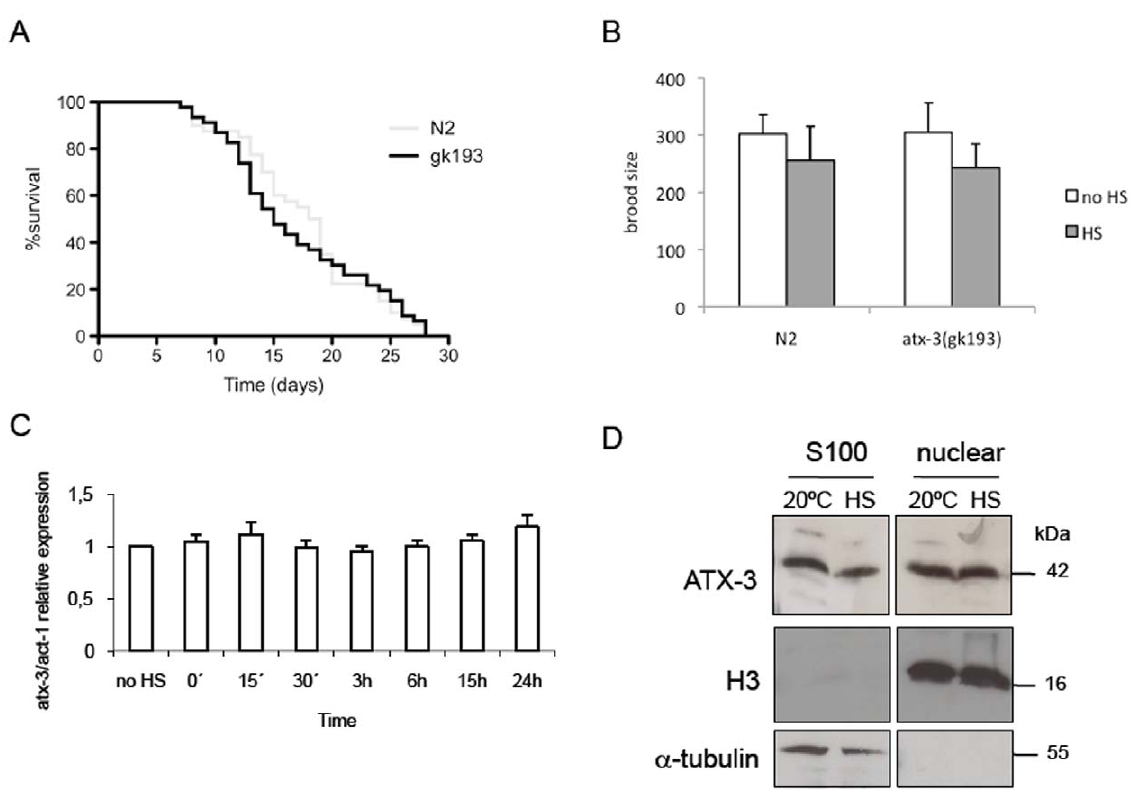
Figure 6. Atx-3 expression does not change with stress. ( A ) Exposure to heat shock early in life does not extend C. elegan s atx-3 mutants lifespan nor does it change the number of progeny when compared to wild type ( B ). ( C ) Atx-3 mRNA levels remain similar after a heat shock in C. elegans . No HS: no heat shock, 15 9 : 15 minutes of recovery at 20 u C after the 2 h HS at 33 u C, 30 9 : 30 minutes of recovery, 3 h–24 h: 3 hours-24 hours of recovery. ( D ) No differences in ATX-3 protein levels were detected in the cytoplasm and in the nucleus, neither in a basal condition nor after heat stress. H3: histone H3; S100: cytoplasmic fraction.